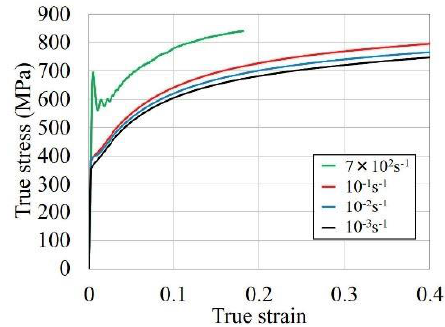
Fig. 2. True stress-true strain relations for SM490B.